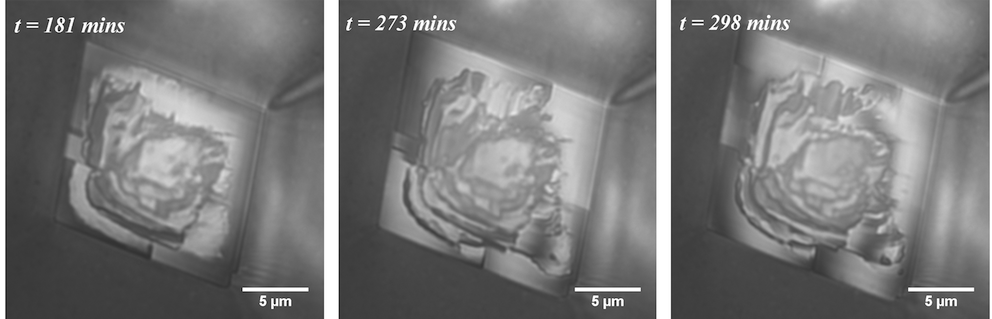
Figure 3. Six hours of growth of Crystal B at Ω = 0.4. Dark areas along the rim of the crystal signify areas of contact between crystal and glass. One observes that for Crystal B, these contact areas move intermittently from place to place along the rim with time.